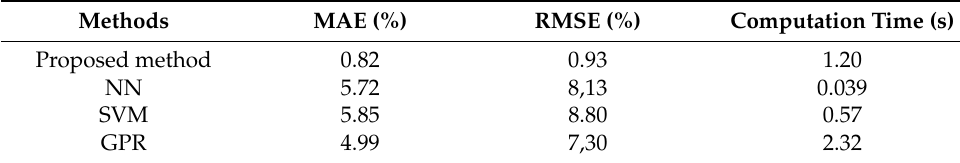
Table 6. Results of the estimation.